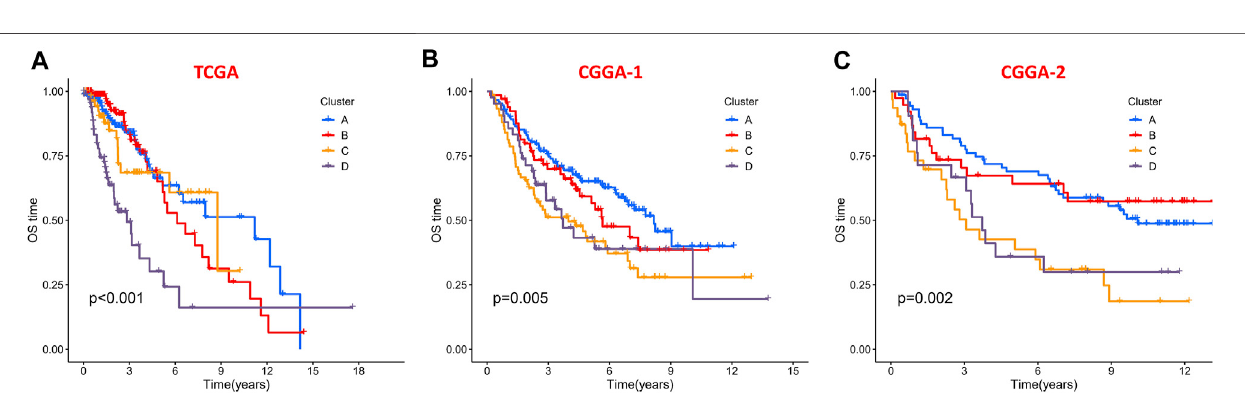
FIGURE 6 | Kaplan – Meier survival curves of the four clusters in the (A) TCGA dataset, (B) CGGA-1 datasets, and (C) CGGA-2 datasets.